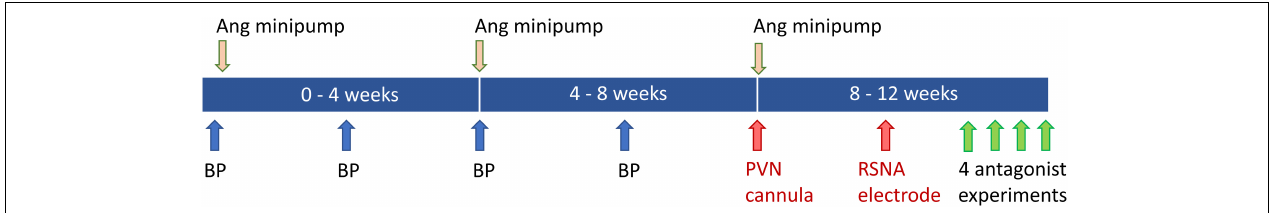
FIGURE 1 | Schematic diagram showing timeline of blood pressure (BP) measurements at baseline and weeks 2, 4, and 6. Angiotensin (Ang) minipumps were inserted at baseline and changed at week 4 and 8. Surgery to implant the PVN cannula and renal sympathetic nerve activity (RSNA) electrode was carried out at weeks 8 and 10. Experiments to examine effects of antagonists, agonist and vehicle occurred during week 12.